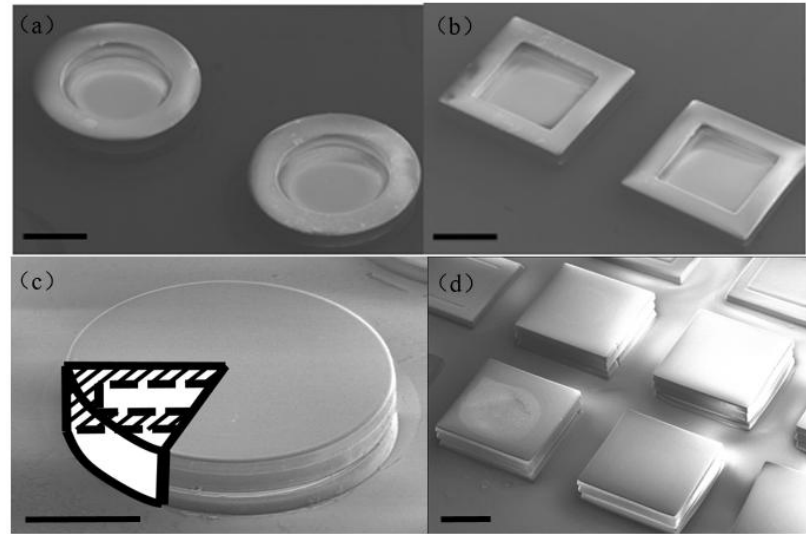
Figure 3. Scanning electron microscope (SEM) images of cylindrical ( a ) and cuboid ( b ) magnetic hollowbots before photopatterning top layer. ( c ) SEM image and sketch of the photopatterned magnetic cylindrical hollowbot structure. ( d ) SEM image of the photopatterned magnetic cuboid hollowbots. Scale bars = 100 µm.